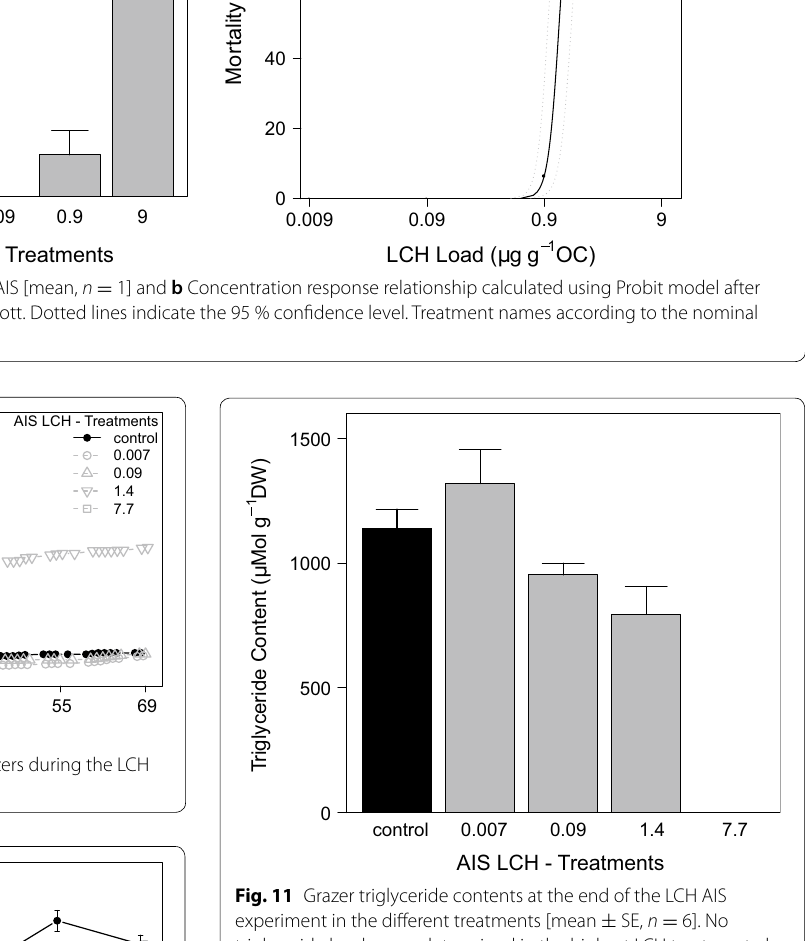
Triglyceride levels in treatments 0.09 µg g − 1 OC and 796 110 µMol g − 1 (Fig. 11). ±